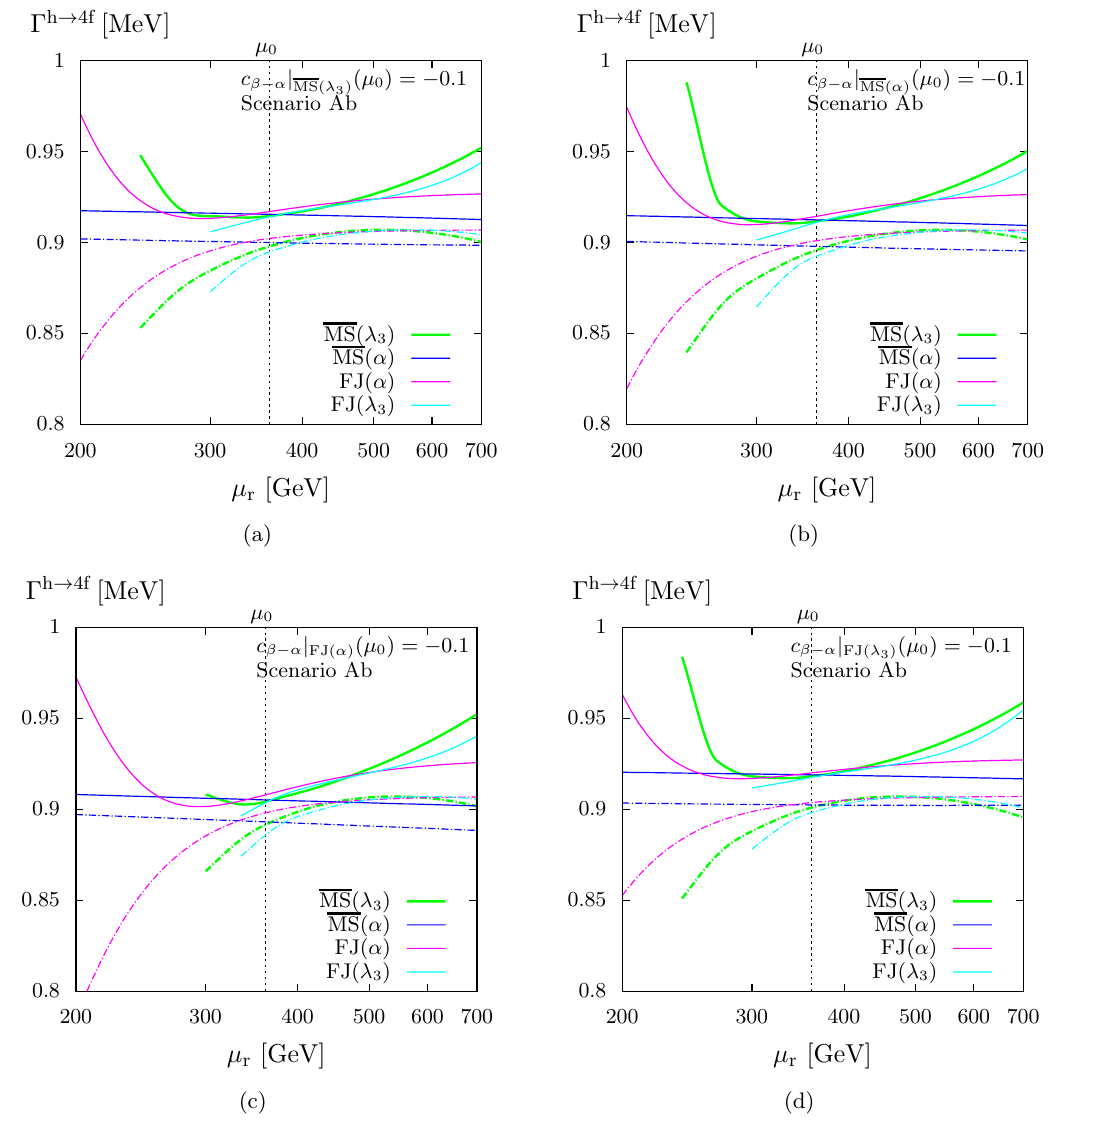
Figure 11 . As in (cid:12)gure 10, but for scenario